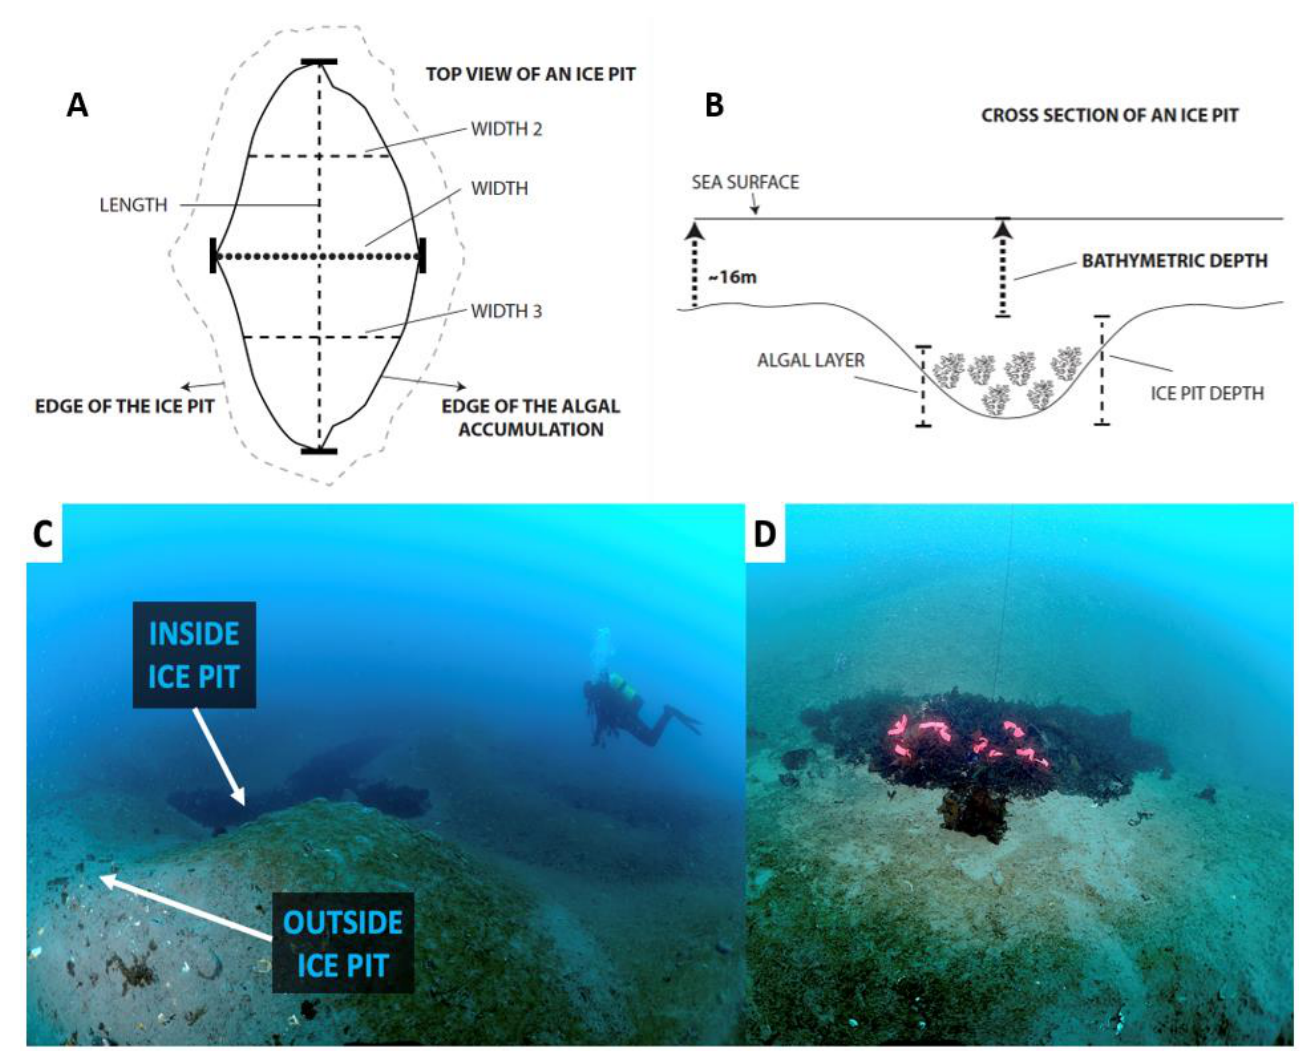
Figure 3. ( A ) Top view and ( B ) cross-section schematic representations of the dimensions recorded for ice pits. ( C ) Locations indicating inside and outside an ice pit (photo at 17 m from 2018). ( D ) Orange-colored straight-line polyvinyl chloride (PVC) flagging tape was deployed in ice pits to experiment with advective loss (photo at 15 m from 2018). Table 1. Geographical positions, dimensions, and algal biomass of ice pits. Six ice pits were not sampled for algal composition. For large ice pits, multiple length and width dimensions were meas- ured, and the average values are shown here. Algal thickness was measured in the center of each ice pit; pit volume was calculated using a hemi-ellipsoid formula; and the Area-Specific Biomass (ASB) was based on the mean of two 0.25-m 2 quadrats in each ice pit.